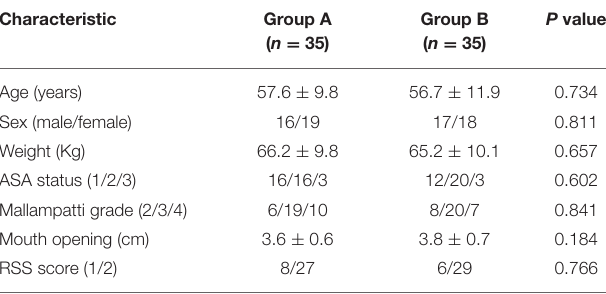
TABLE 1 | Demographic and clinical characteristics of study participants.